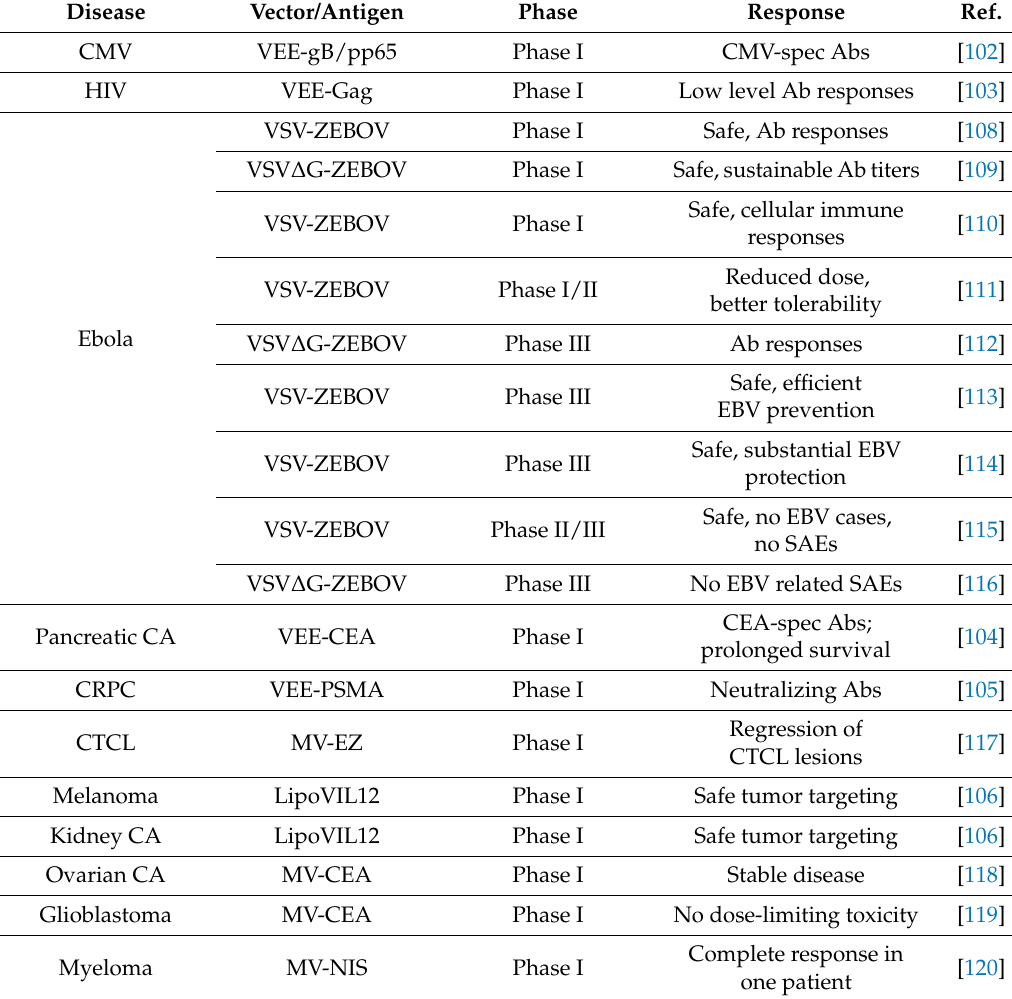
Table 3. Examples of clinical trials applying self-replicating RNA